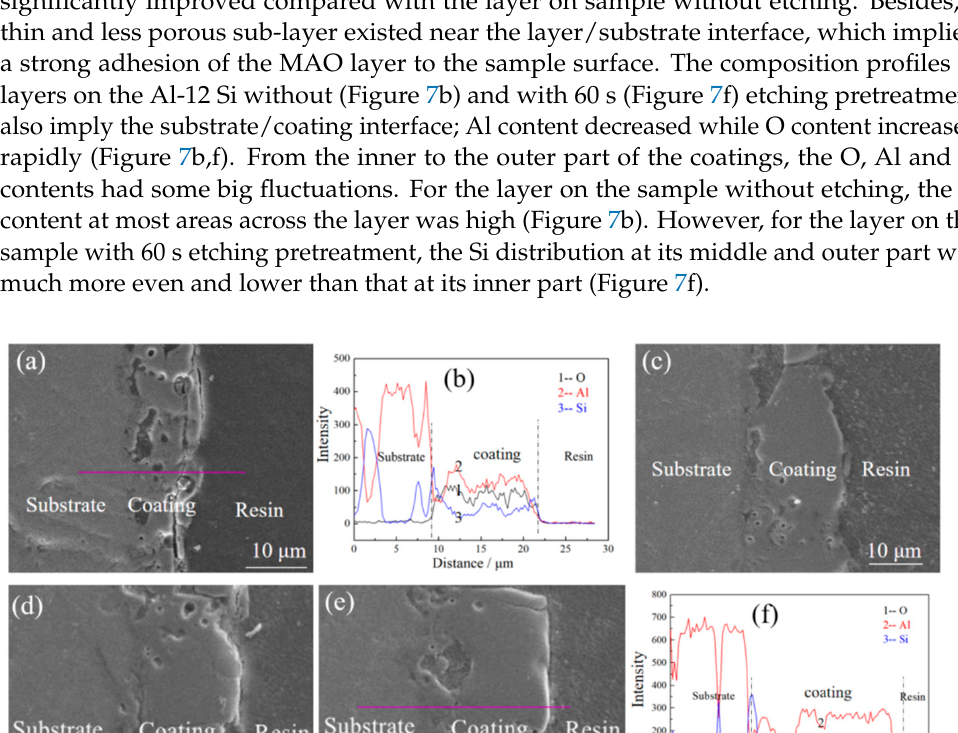
Figure 6. Surface morphology of the coatings on the Al-12 Si by ( a – d ) 0, 15, 30 and, 60 s etching, and then 30 min of MAO treatment.